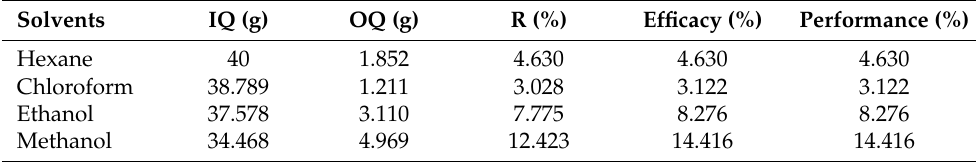
Table 1. Percentages of extraction yield, efficacy, and performance, after 48 h of extraction.